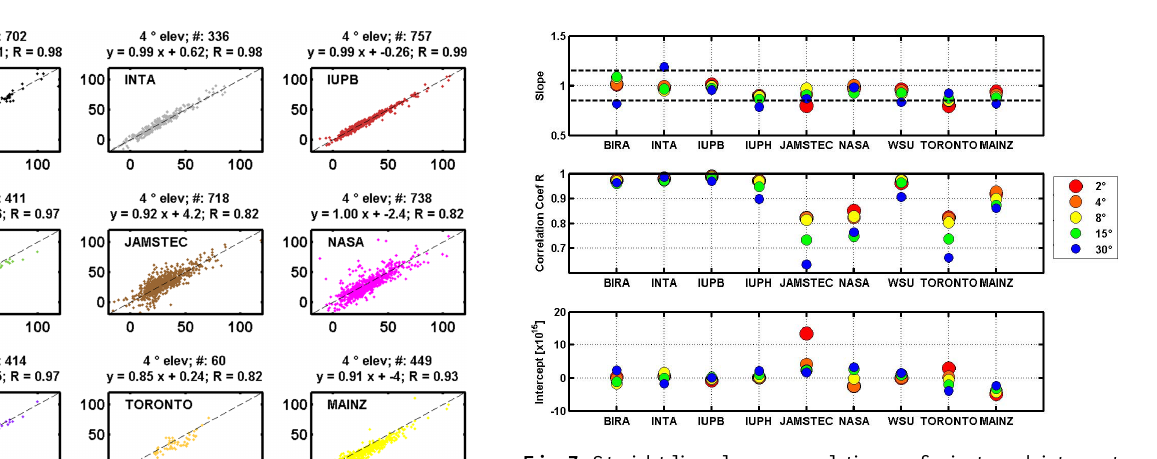
Fig. 7. Straight-line slopes, correlation coefficients and intercepts of HCHO slant columns against those of the reference, for each instrument and all off-axis elevation angles. The dotted lines in the first panel correspond to values of 1.15 and 0.85.